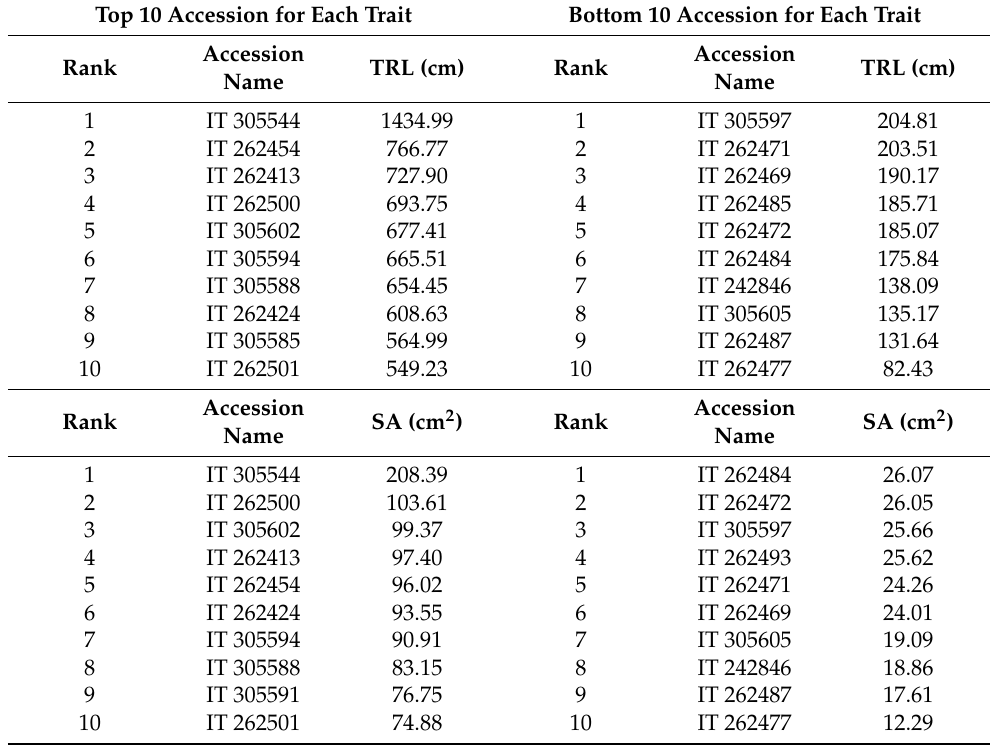
Table 3. List of highest and lowest-ranking accessions for each root trait. Top 10 Accession for Each Trait Bottom 10 Accession for Each